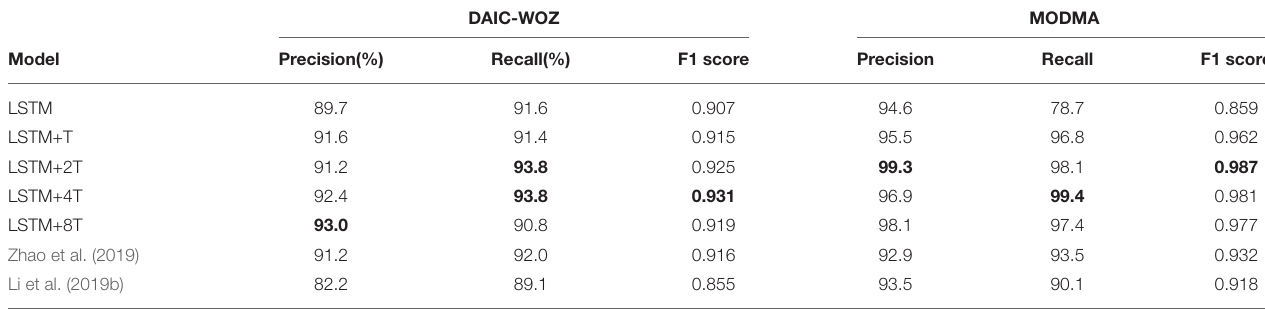
TABLE 3 | Comparison between long short-term memory (LSTM) and the proposed model.